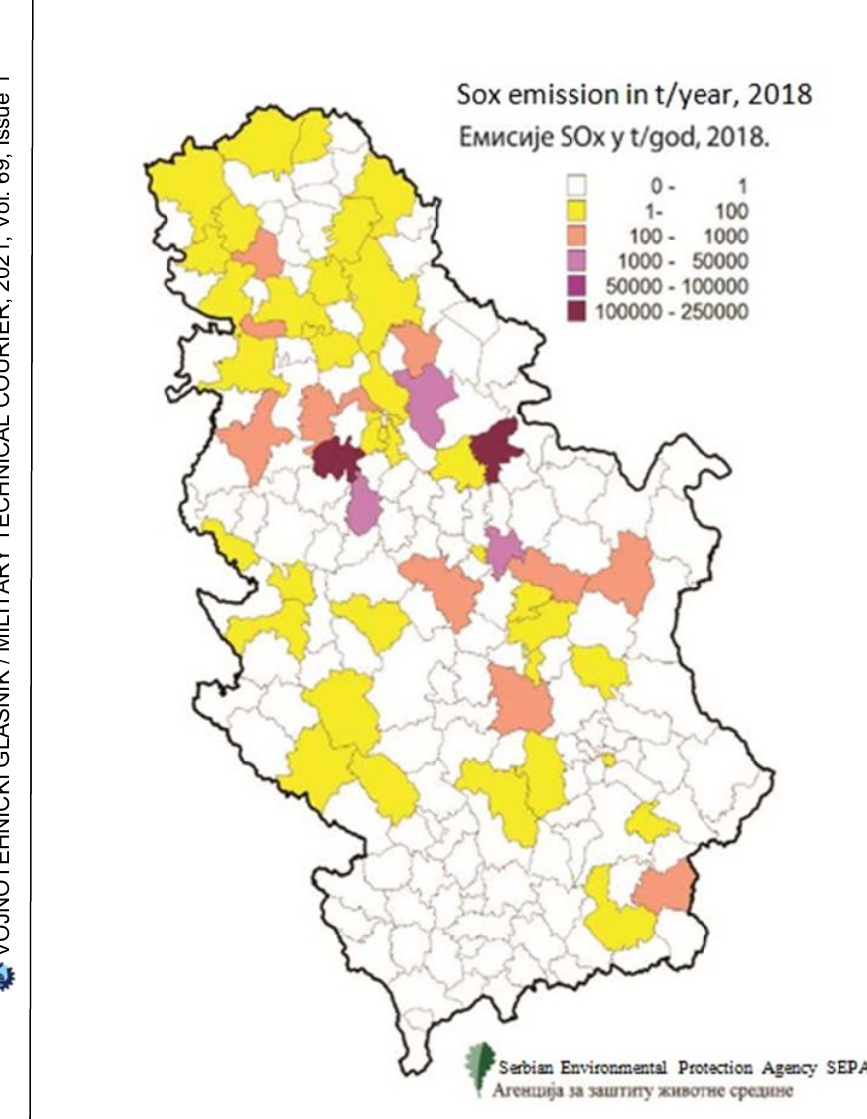
(Environ Рисун муници